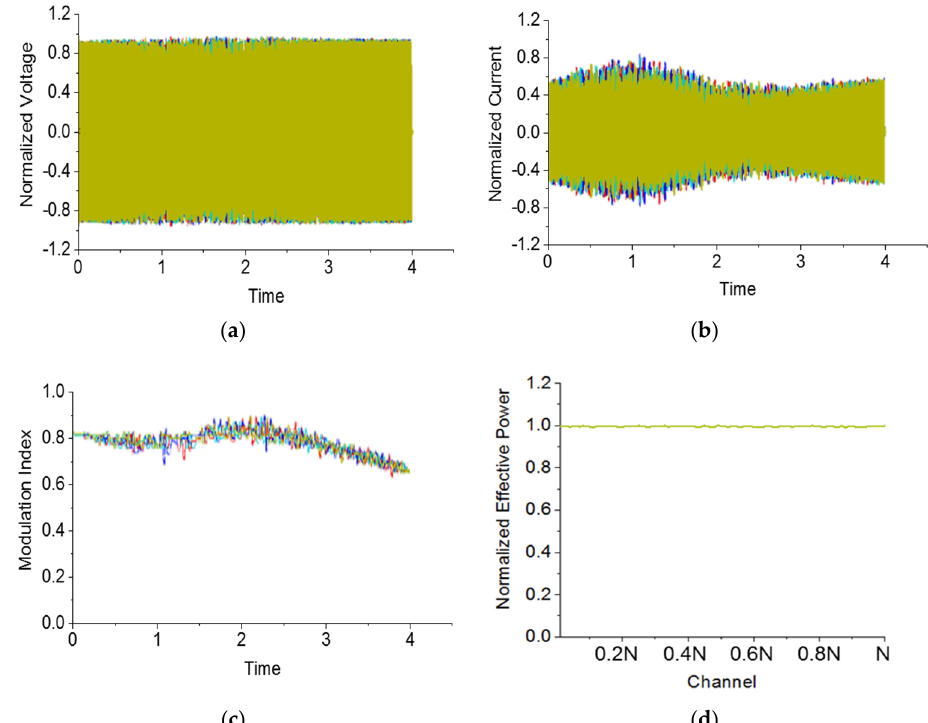
Figure 12. The output voltage and current with CPVC in the MCAT load: ( a ) the normalized output voltage; ( b ) the normalized output current; ( c ) the modulation index; ( d ) the normalized effective power at each transducer.